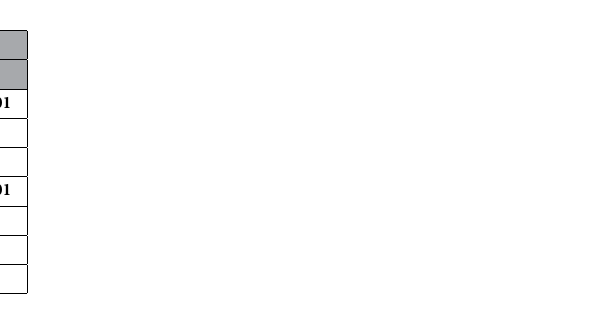
Table 2. Results of the linear mixed effects model evaluating the effect of fixed factors day, treatment, and genotype on tissue loss in A. cervicornis . Significance at P < 0.05 is noted in